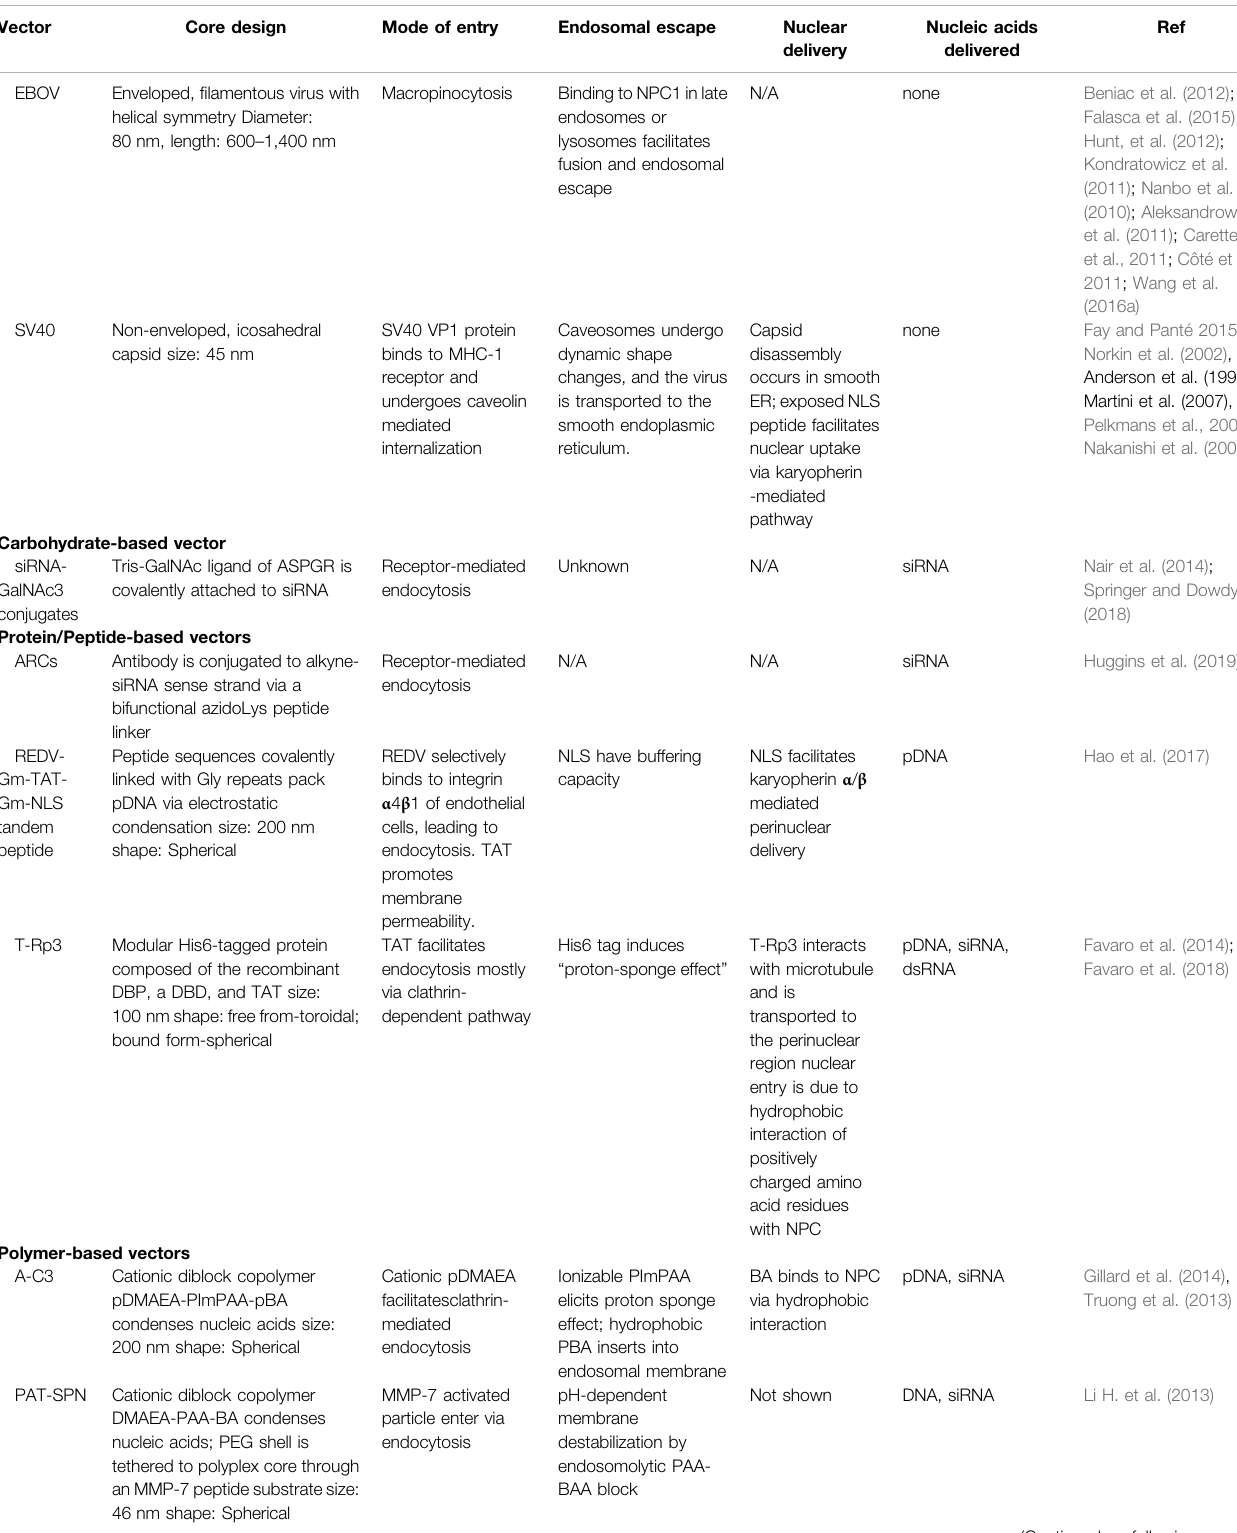
TABLE 1 | ( Continued ) Nucleic acid carriers: Properties and traf fi